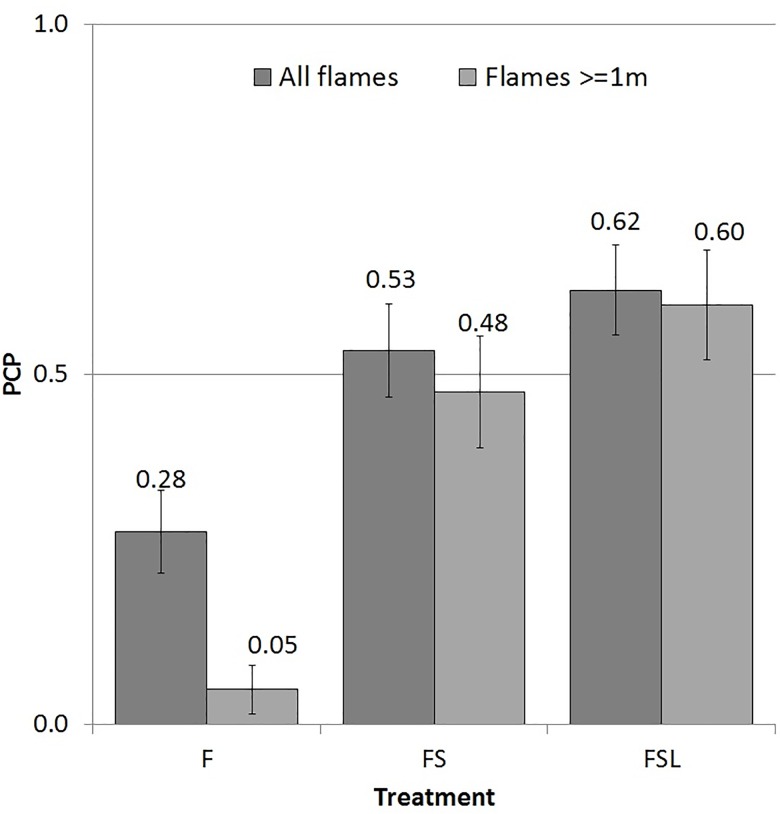
Proportion of correct predictions for each model treatment for the full flame height dataset (PCP) and for flames ≥1m (PCP1).PCP calculations were based on all 58 sites; PCP1 calculations were based on the 40 sites with flame heights ≥1m. Error bars show one standard error above and below the mean.